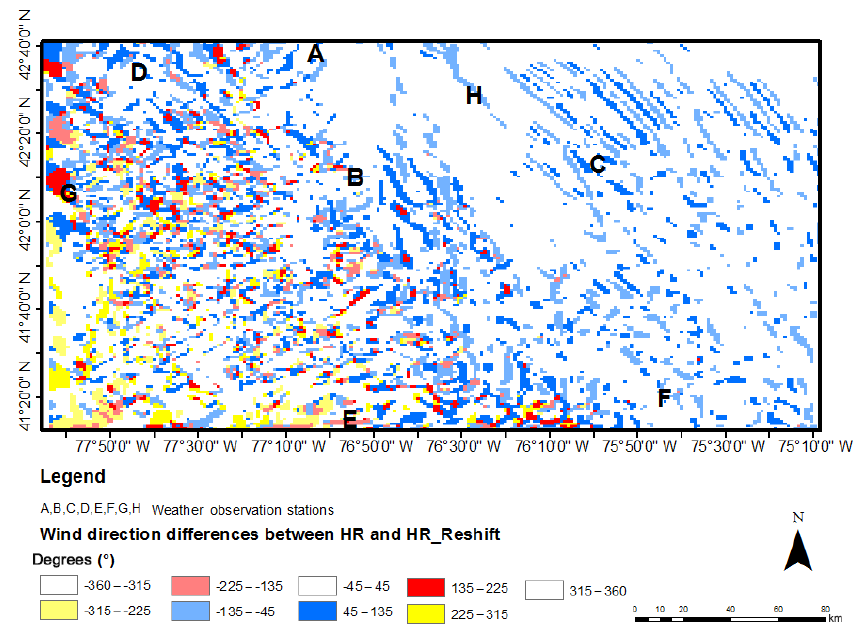
Figure 16. Wind direction difference between HR and HR_RESHIFT on 14 May 15:00EST, 2015, showing a strip pattern in the right top corner where it is a valley region. The pattern indicates that the WRF model reacts differently on a small-area weather simulation when the GCS changes.